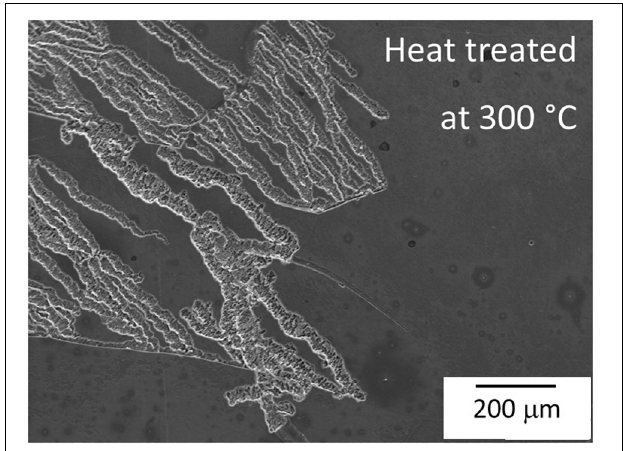
FIGURE 13 | SEM micrograph of severe localized corrosion of heat treated Mg-10Gd at 300 ◦ C after 3 h exposure in 0.5 wt.% NaCl solution.